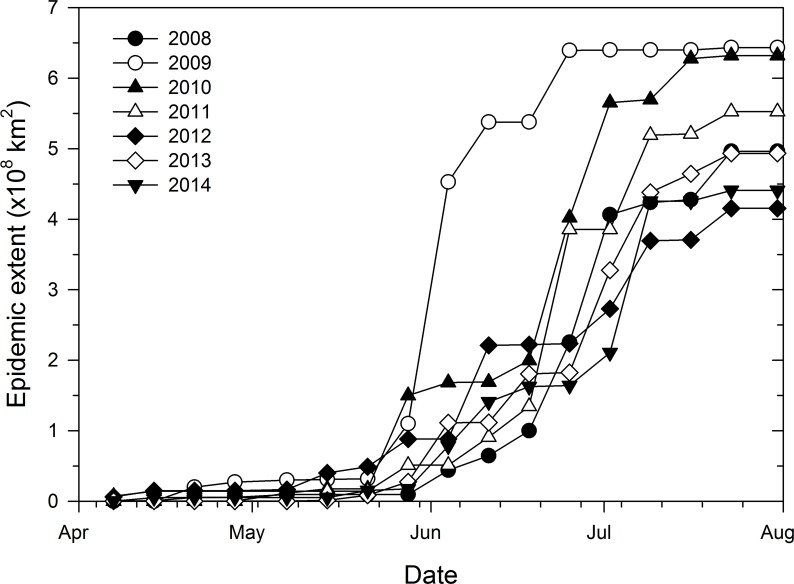
Progress of epidemic area of cucurbit downy mildew based county-level reports of disease outbreaks.Temporal progress of weekly epidemic area of cucurbit downy mildew in the eastern United States based on county-level cumulative reports of new disease outbreaks.